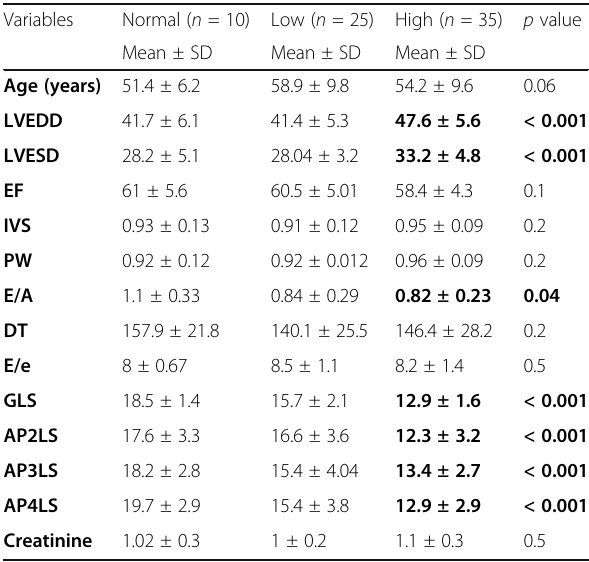
Table 1 Comparisons of SYNTAX score categories with echo findings Variables